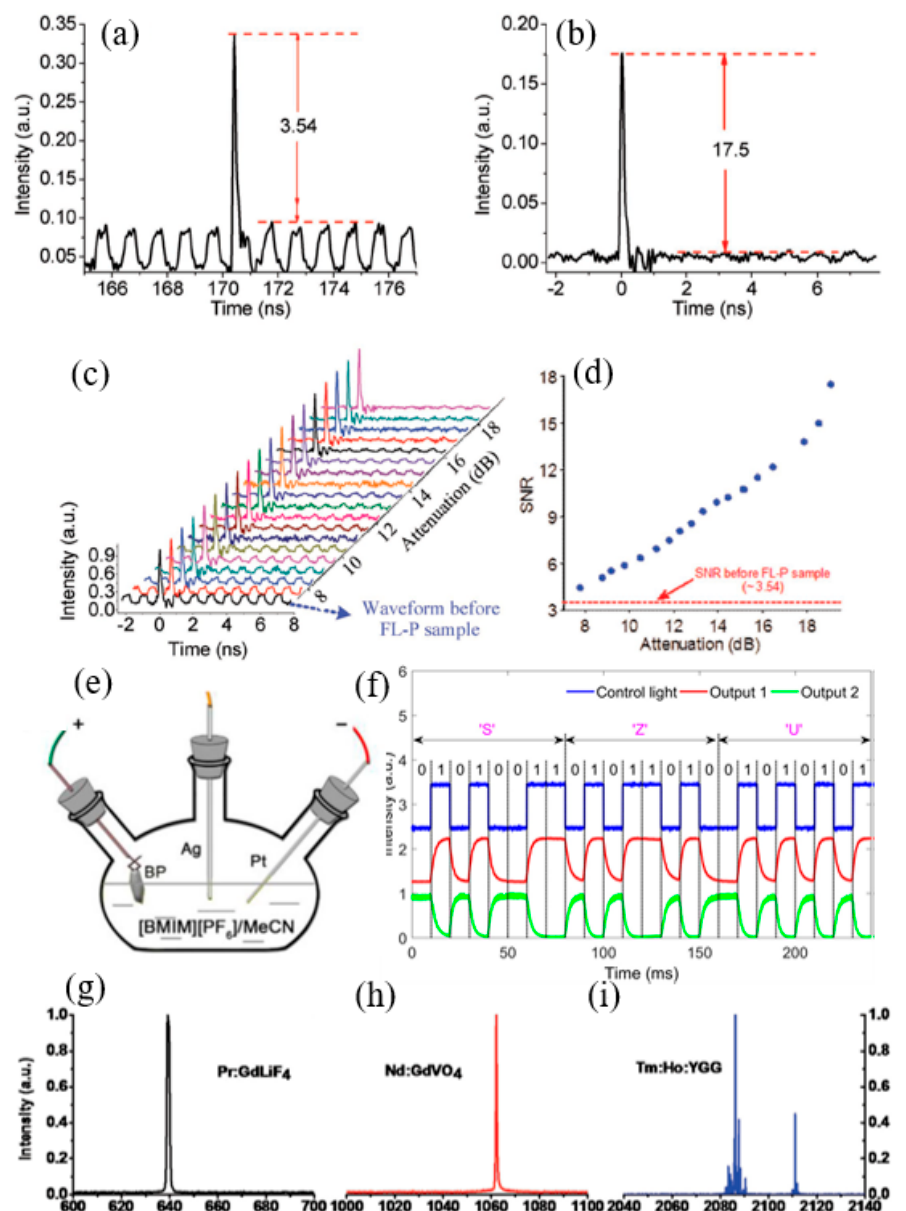
Figure 10. ( a ) Experimental results of all-optical threshold: the optical pulse waveform before entering the threshold device. ( b ) The optical pulse waveform after passing through the threshold device. ( c ) Time pulse waveform evolution diagram of different incident light power. ( d ) The corresponding signal-to-noise ratio at different incident optical power [262]. Copyright 2017 John Wiley and Sons Inc. ( e ) Schematic diagram of FP synthesis in an electrochemical stripping unit. ( f ) ASCII codes of ‘S’, ‘Z’, and ‘U’ obtained by control light and output ports [263]. Copyright 2018 Wiley-VCH Verlag. ( g ) 639 nm, ( h ) 1.06 µ m, and ( i ) 2.1 µ m passively modulated volume lasers, respectively [264]. Copyright 2015 John Wiley and Sons